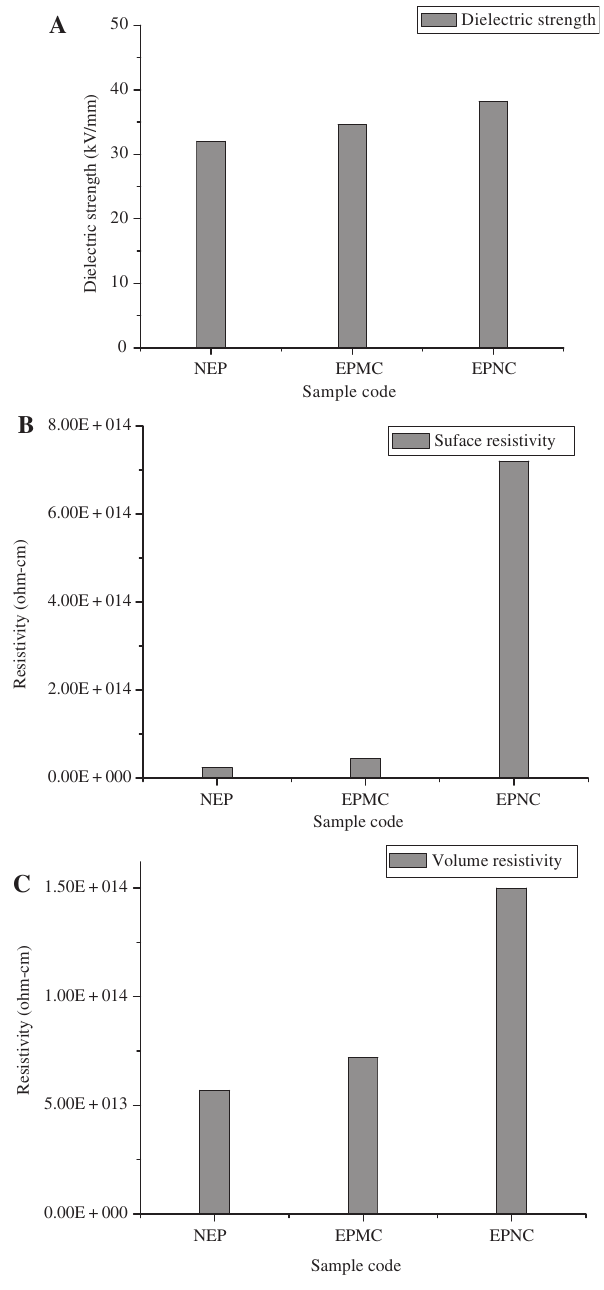
Figure 5: (A) Dielectric strength of NEP, EPMC, and EPNC; (B) surface resistivity of NEP, EPMC, and EPNC; (C) volume resistivity of NEP, EPMC, and